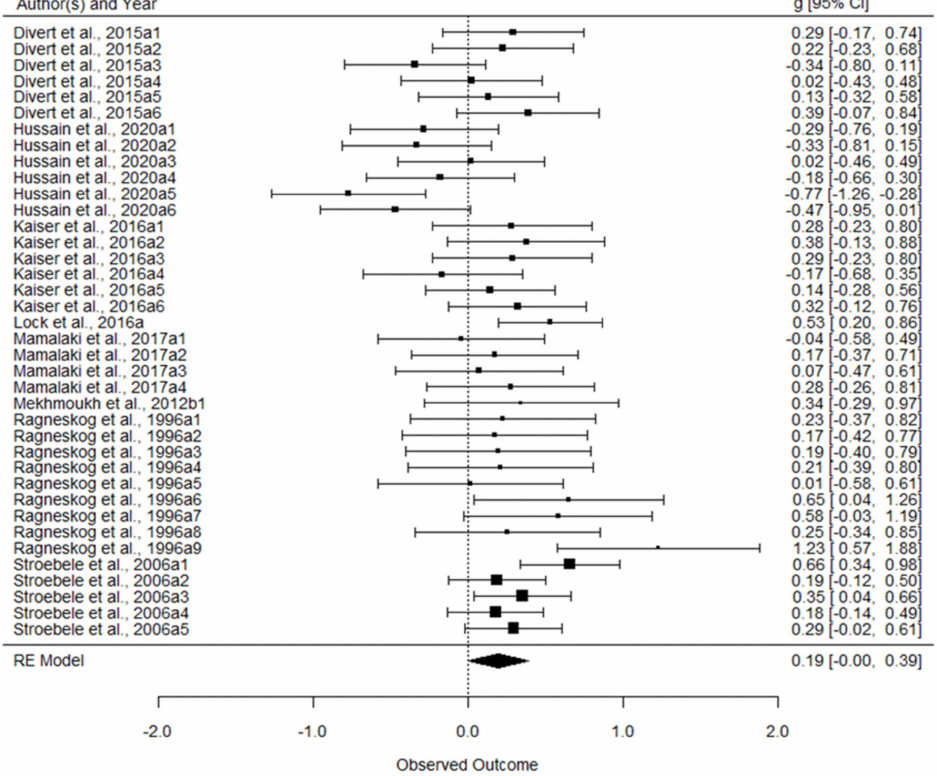
Figure 2. Forest plot of effect sizes (g)